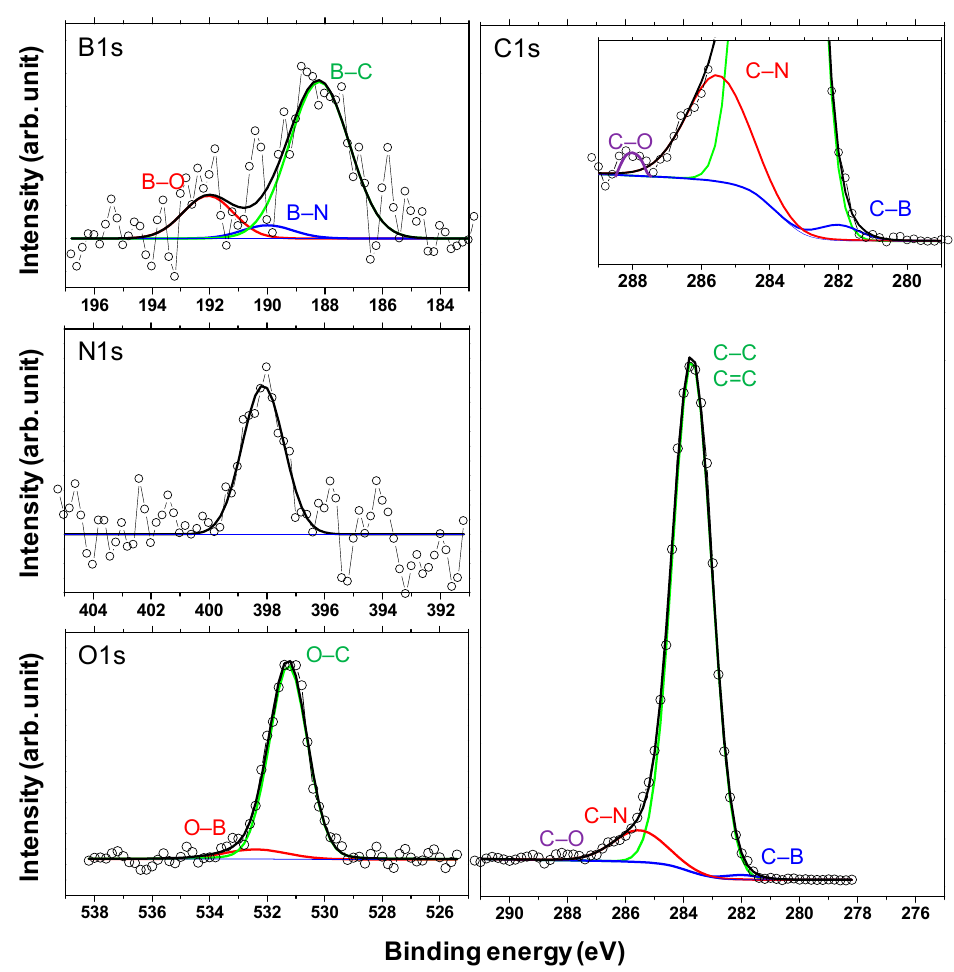
Figure 16. Deconvoluted B 1s, N 1s, C 1s, and O 1s X-ray photoelectron spectra of the a-BCN films.